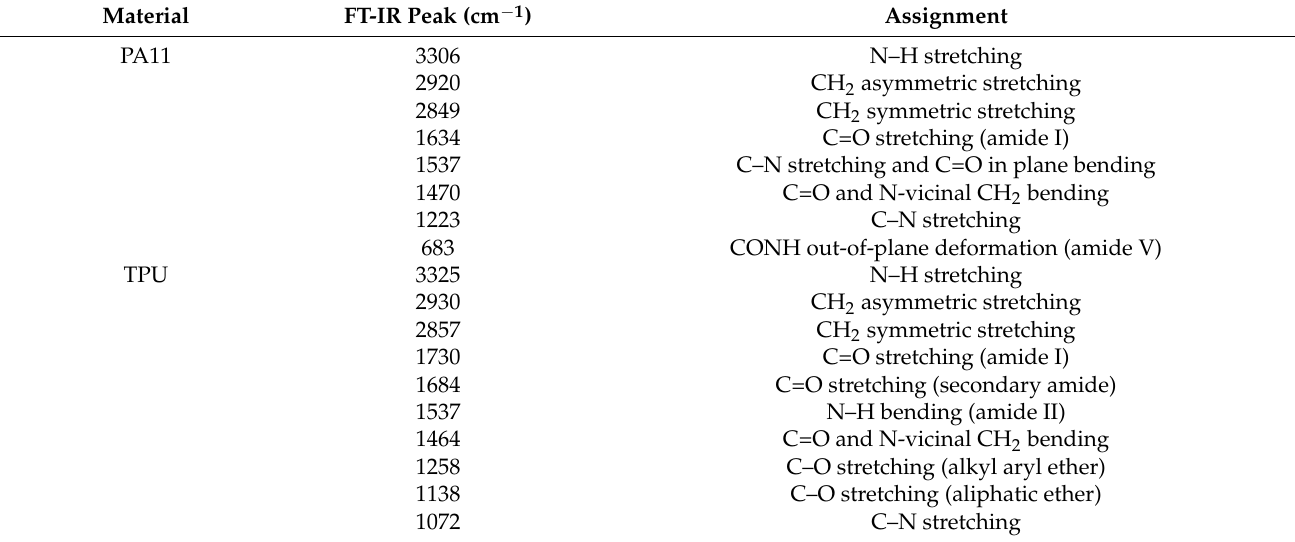
Table 2. Functional group assignments for both powders.